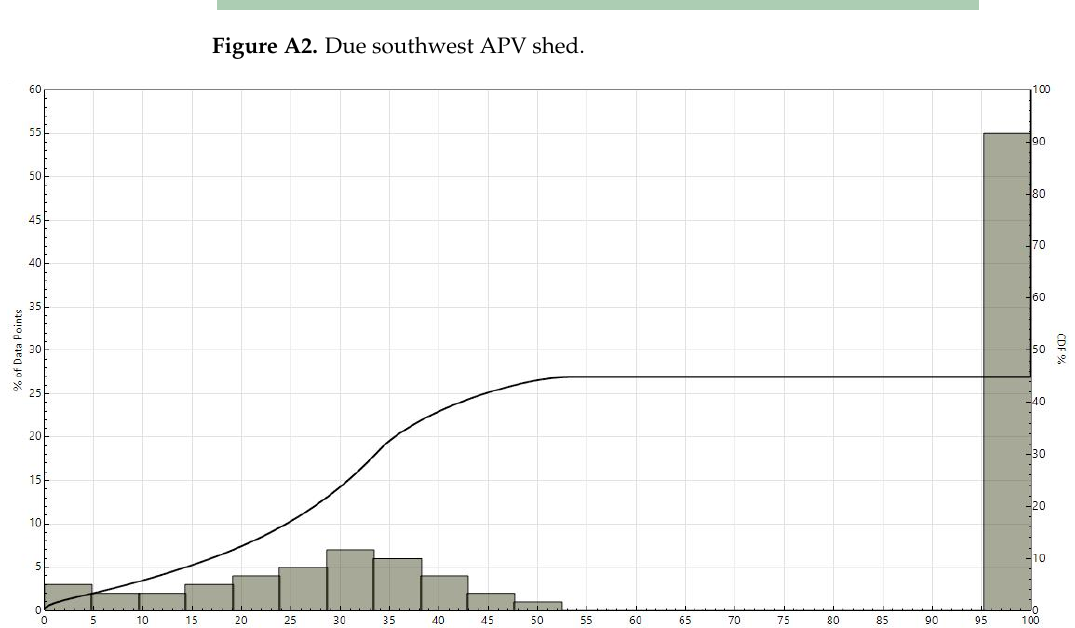
Figure A3. Time series (1 min step) shaded fraction histogram (zero values excluded) for due south orientation.